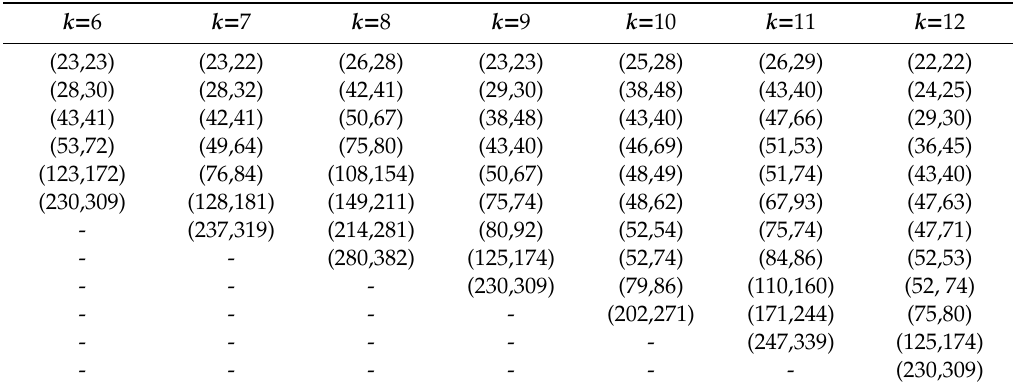
Table 2. Clustering prediction boxes corresponding to di ff erent k values.